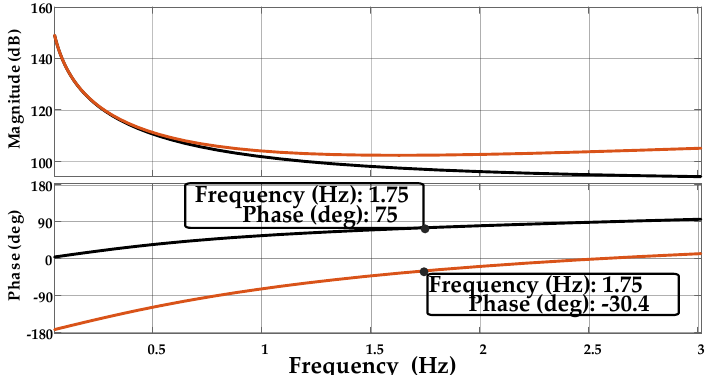
∆ ω e / BPSS with and without compensation.